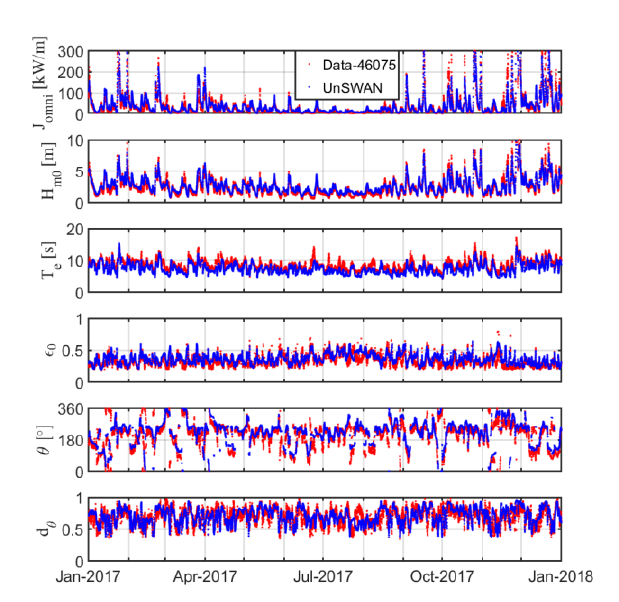
Fig. 7. Comparison of observed and simulated six IEC resource parameters for year 2009 at NDBC buoy 46027 in the West Coast. From top to bottom: omnidirectional wave power, significant wave height, energy period, spectral width, direction of maximum directionally resolved wave power, and directionality coefficient. Buoy location is shown in Fig. 2.